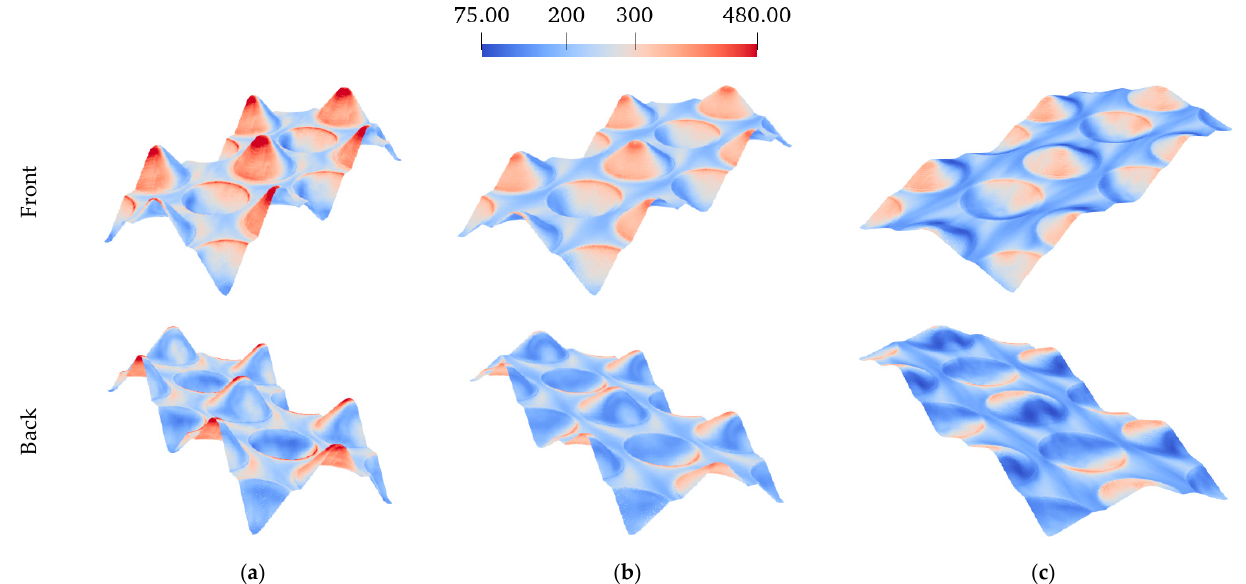
Figure 9. Front and back view of the temporal mean of the local Nu number for the three levels of roughness. ( a ) H = 60 μm ; ( b ) H = 40 μm ; and ( c ) H = 20 μm.